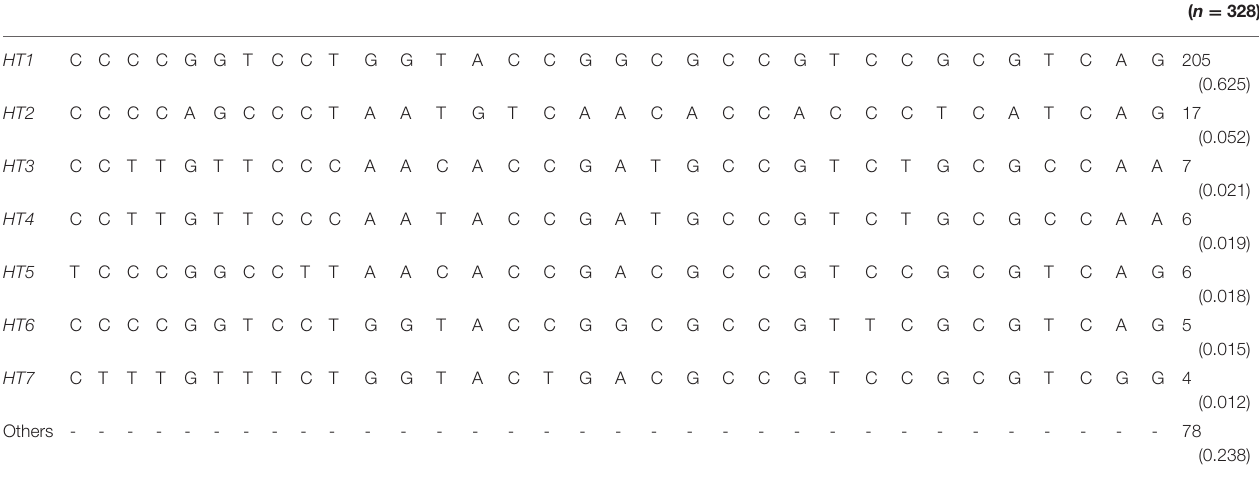
TABLE 4 | Haplotype frequencies of the quail prion protein gene ( PRNP ).